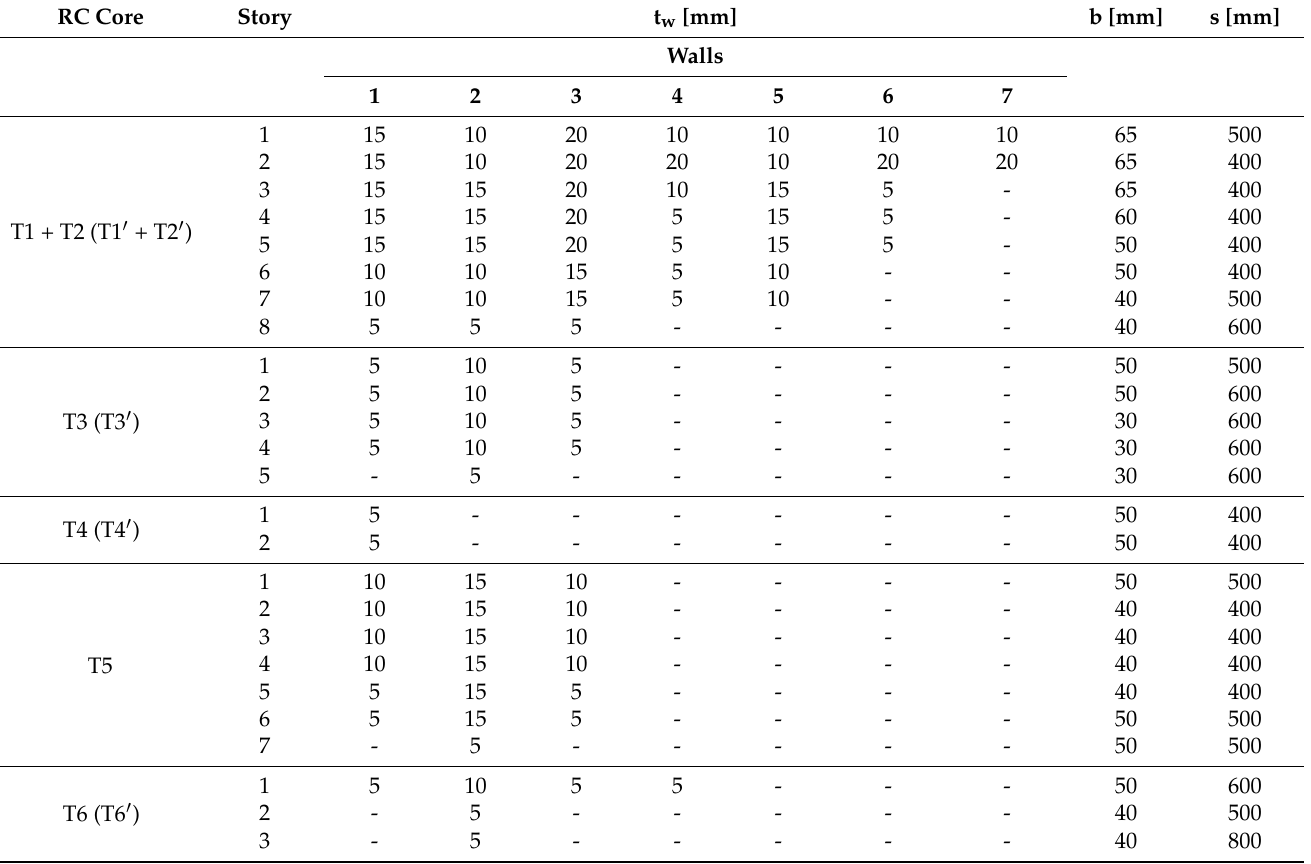
Table 14. Disposition of the horizontal strips in I2 ( ζ E ≥